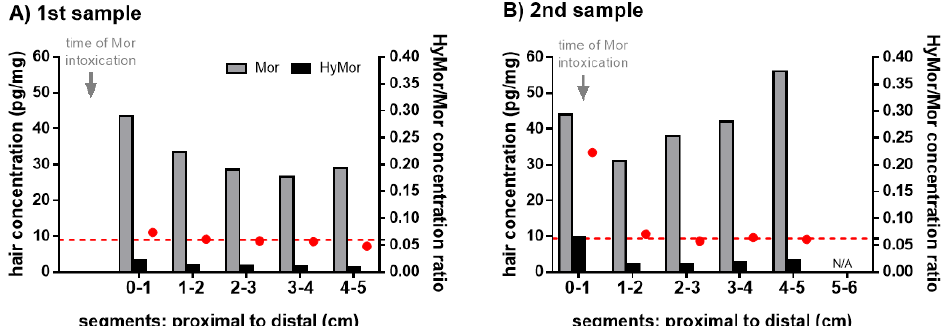
Figure 1. Morphine (Mor, gray bars) and hydromorphone (HyMor, black bars) concentrations (left y-axis) and HyMor to Mor concentration ratios (red circles, right y-axis) in the hair segments of the 100-year old victim’s 1st ( A ) and 2nd ( B ) sample collected 9 and 51 days after the Mor intoxication, respectively. The red dashed line represents the average of HyMor to Mor concentration ratios of the five segments in the 1st sample and four distal segments in the 2nd sample, respectively (HyMor/Mor in segment 0–1 of the 2nd sample: distinctly different). Table 4. Details on chronic morphine